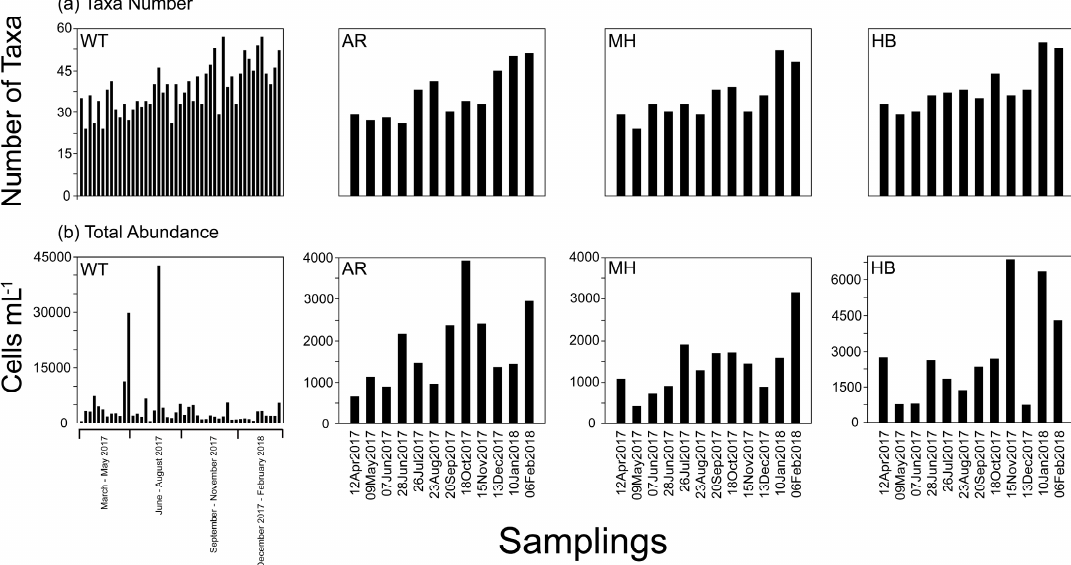
Figure 2. Number of taxa ( a ), and total abundance ( b ) in White Tower (WT), Aretsou (AR), Music Hall (MH), and Harbor (HB). For sampling codes, see also Table 2.